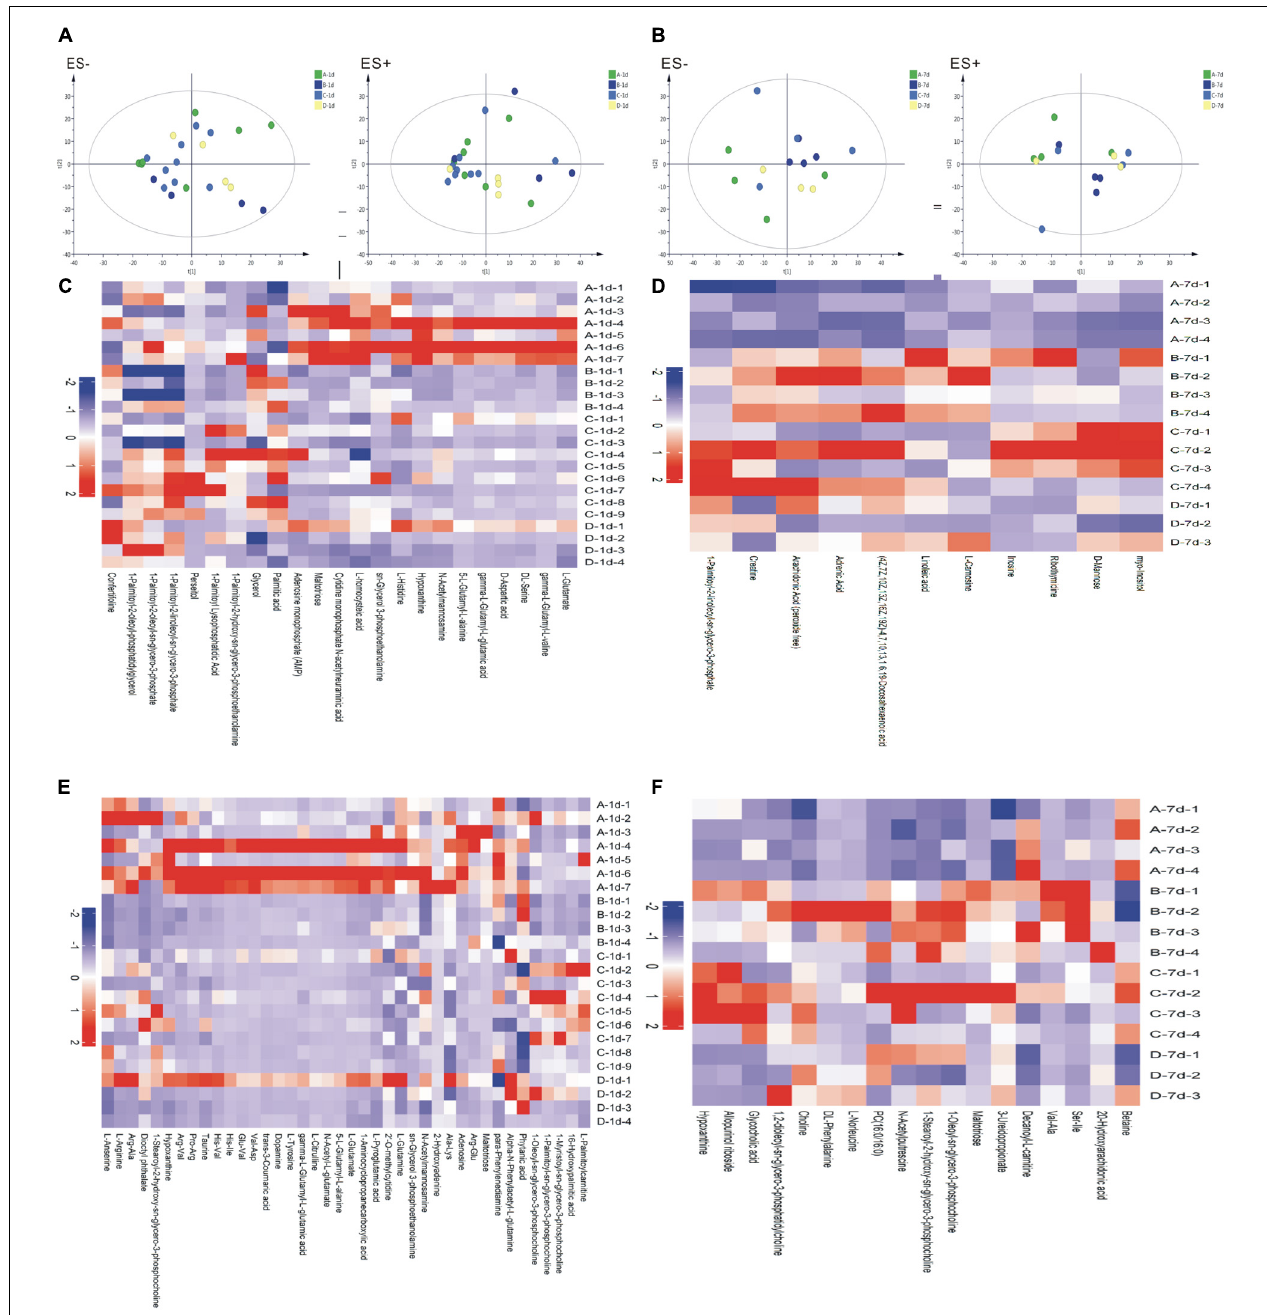
FIGURE 3 | Metabolic profiles. (A,B) Principal component analysis (PCA) based on the metabolic profiles in sputum samples ( A stands for day 1 after birth, B stands for day 7 after birth); (C–F) Hierarchical clustering heat maps showing patterns in molecular data across groups. The relative amounts of the 86 compounds were transformed into Z scores ( C stands for day 1 after birth and ES-, D stands for day 7 after birth and ES − , E stands for day 1 after birth and ES + , F stands for day 7 after birth and ES+) (ES+: positive ion mode, ES-: negative ion mode) (A, severe BPD; B, moderate BPD; C, mild BPD; D, non-BPD). On day 1, the number of infants in A, B, C, D group was 7, 4, 9, and 4, respectively. On day 7, the number of infants in A, B, C, D group was 4, 4, 4, and 3, respectively.